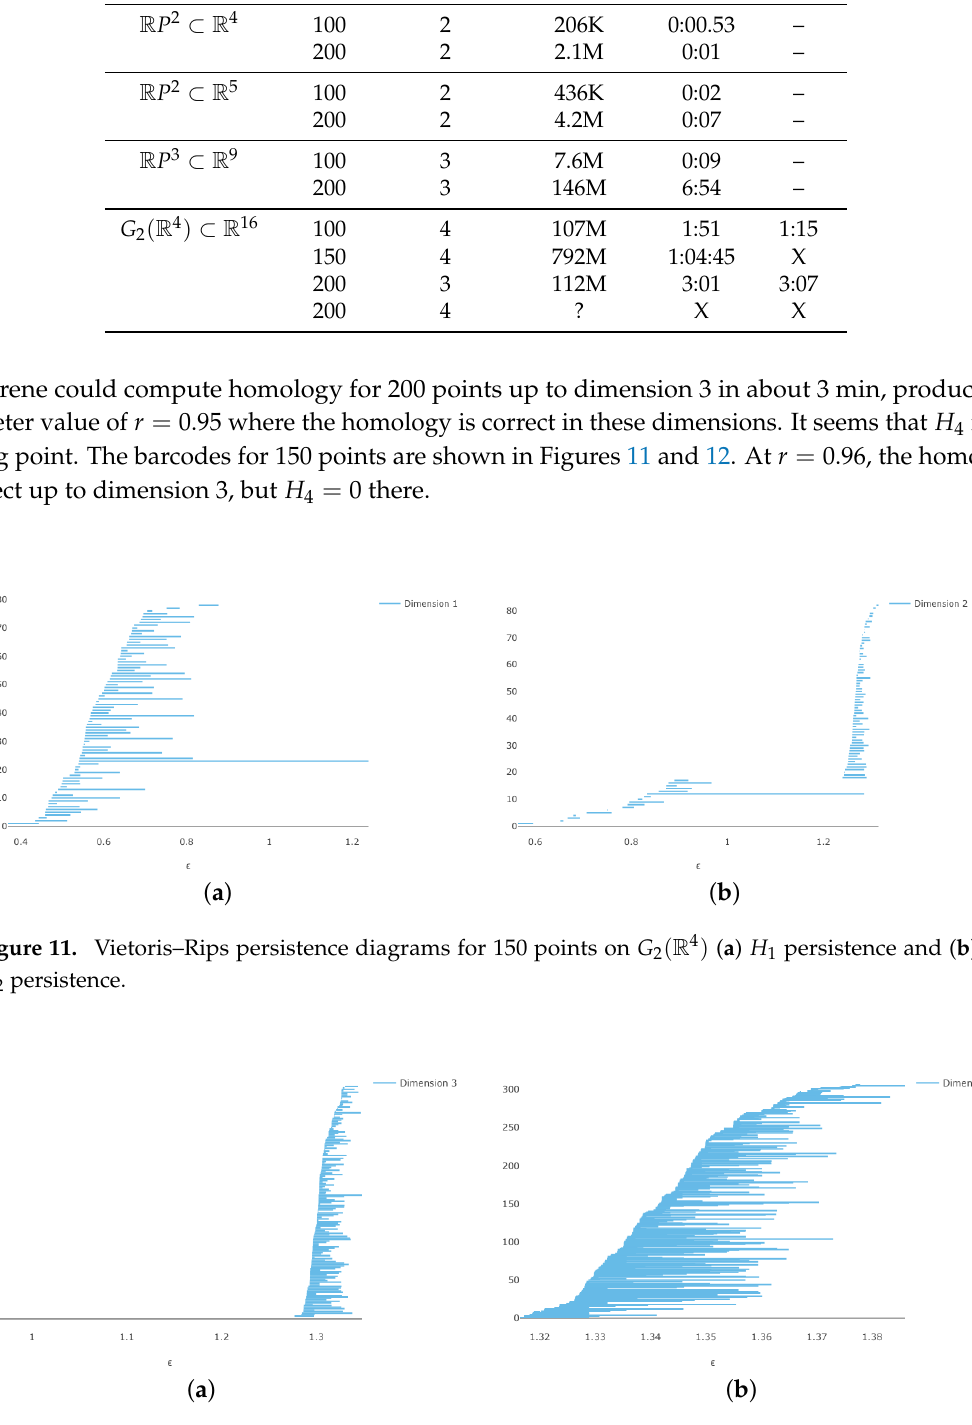
Figure 12. Vietoris–Rips persistence diagrams for 150 points on G 2 ( R 4 ) ( a ) H 3 persistence and ( b ) H 4